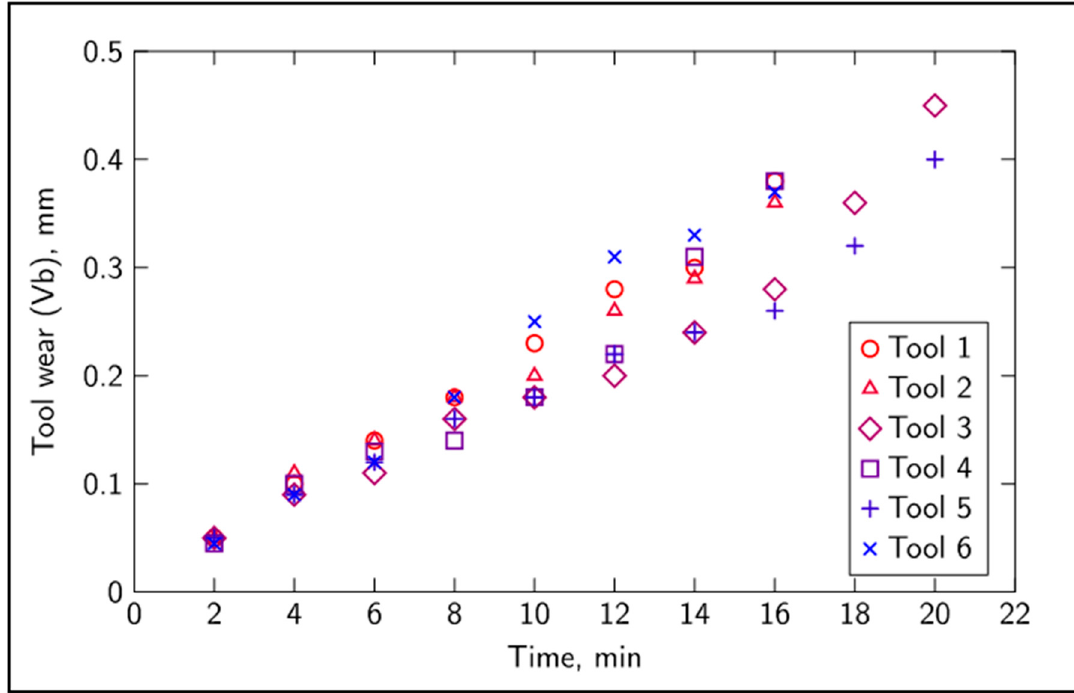
Figure 3. Flank wear evolution over time for all tools.